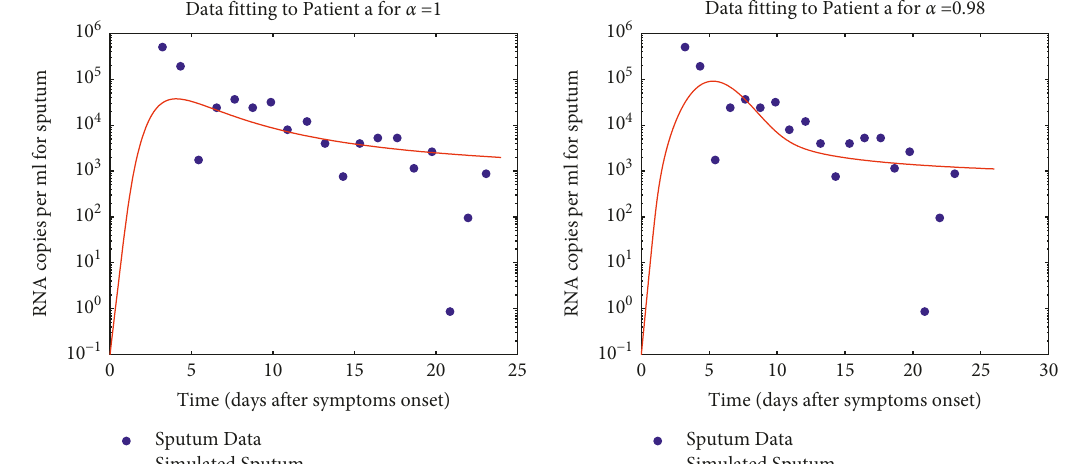
Figure 2: Data fitting for patient c